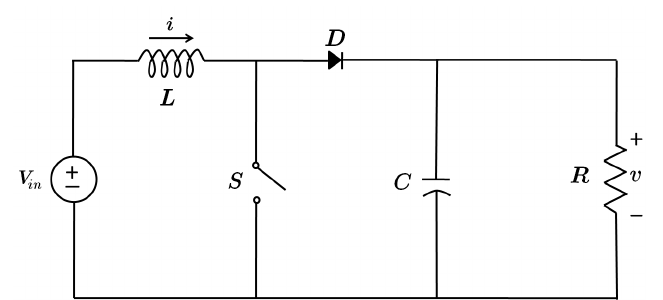
Figure 1. Simplified diagram of the boost